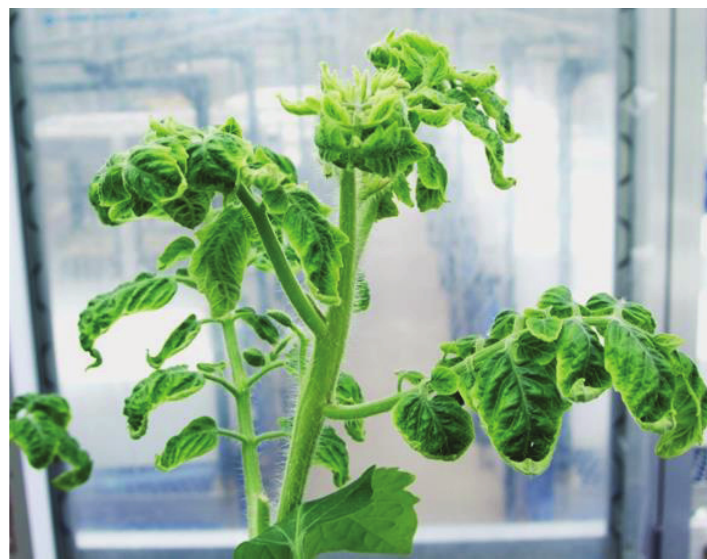
Figure 4. Typical symptoms of TYLCV carried by biotype-Q whiteflies in tomato plants in a hydroponic trough of room A (Figure